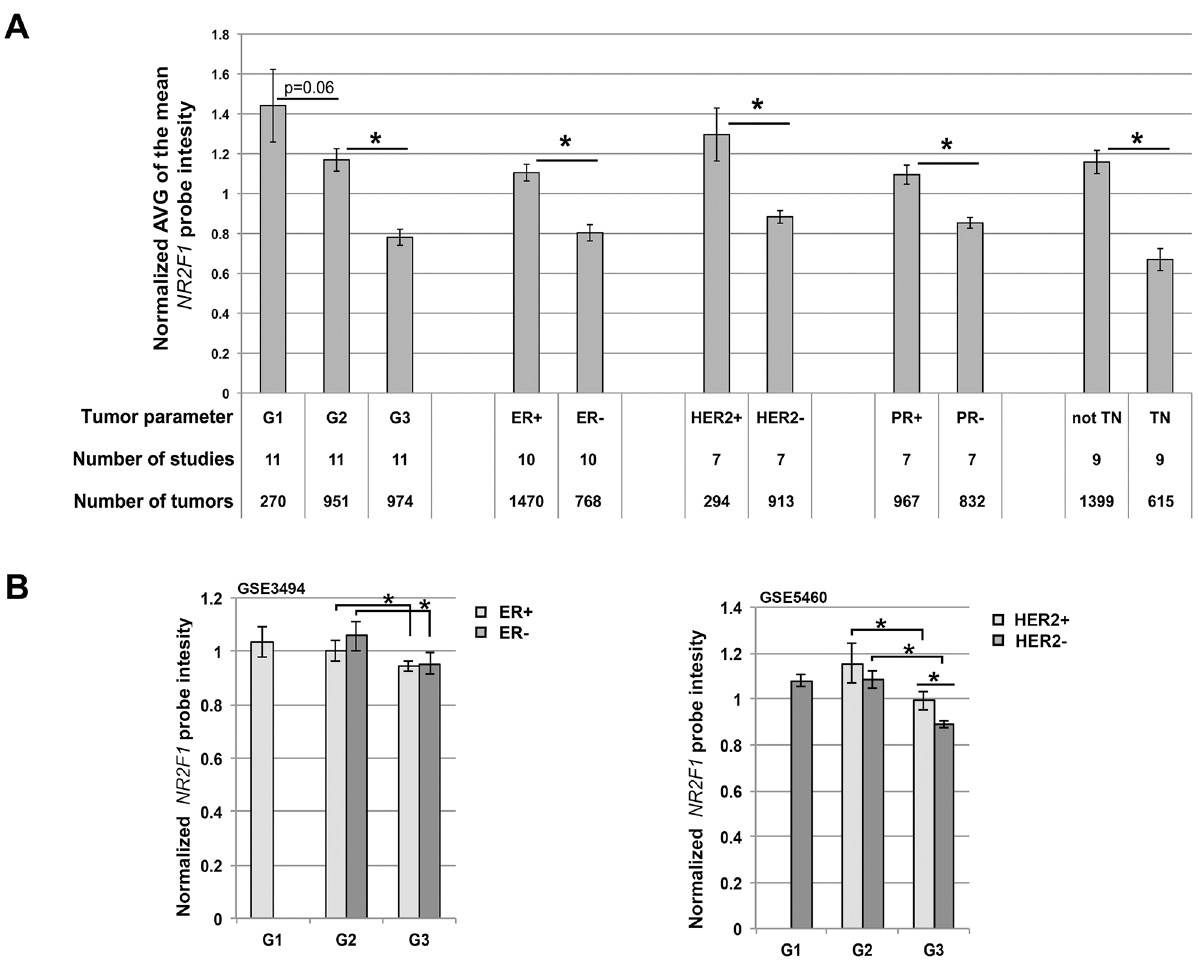
Figure 7. Reduced NR2F1 transcript levels in human breast cancer correlate with histological grade 3 tumors. A) Average ( + / 2 sem) of the normalized median NR2F1 probe intensities, obtained from a total of 12 breast cancer expression studies (with 120 + samples each study) available through Oncomine. G=Histological grade, ER=Estrogen receptor, PR=Progestrone receptor, HER2=Human epidermal growth factor receptor 2, TN=Triple-negative. B) Average ( + / 2 sem) of the normalized NR2F1 probe intensity in sample groups organized by grade and ER status (from GSE3494; left panel) or by grade and HER2 status (from GSE5460; right panel). Left panel: ER + G1 n=62, ER + G2 n=116, ER + G3 n=33, ER-G2 n=11, ER-G3 n=21. Right panel: HER2 + G2 n=7, HER2 + G3 n=23, HER2-G1 n=27, HER2-G2 n=24, HER2-G3 n=46. Significantly different NR2F1 transcript level (P , 0.05) is indicated by an asterisk.